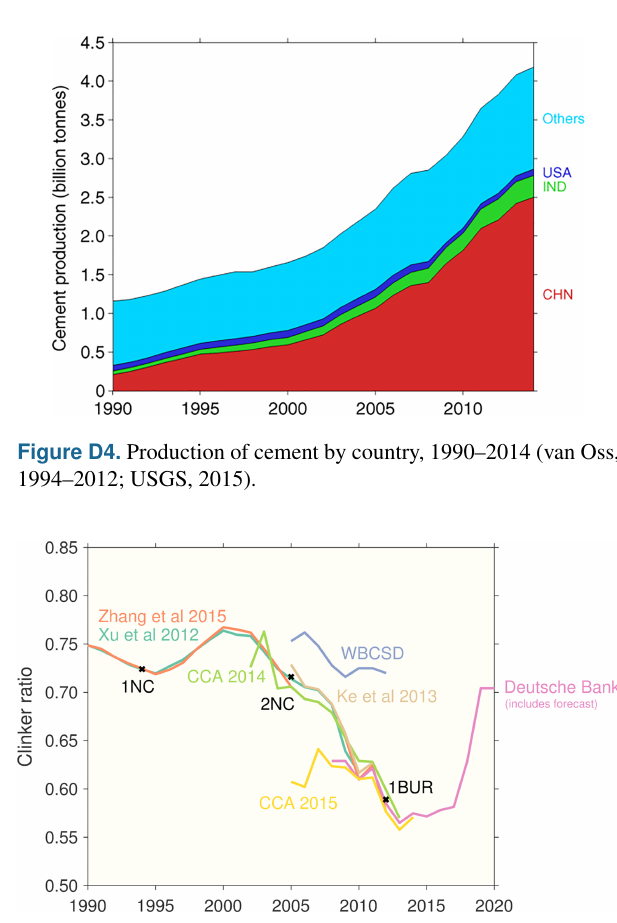
Figure D5. China’s clinker ratio since 1990 from a number of dif- ferent sources. The three official estimates are marked in black: 1NC is the first national communication, 2NC the second national communication, and 1BUR is the first biennial update